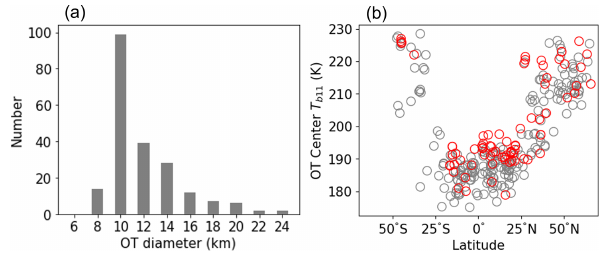
Figure 2. (a) OT diameter distribution of the 209 OT candidates selected from 2007 and 2008 A-Train data. (b) Brightness temper- ature at 11µm of the OT (gray) and NOT (red) center along the CloudSat